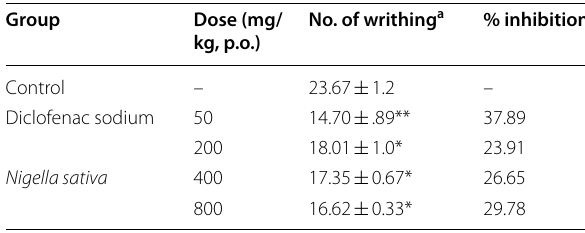
a Presented as mean SEM (n 3) ± = * p < 0.05 compared with the control group (Dunnett’s test) ** p < 0.001 compared with the control group (Dunnett’s